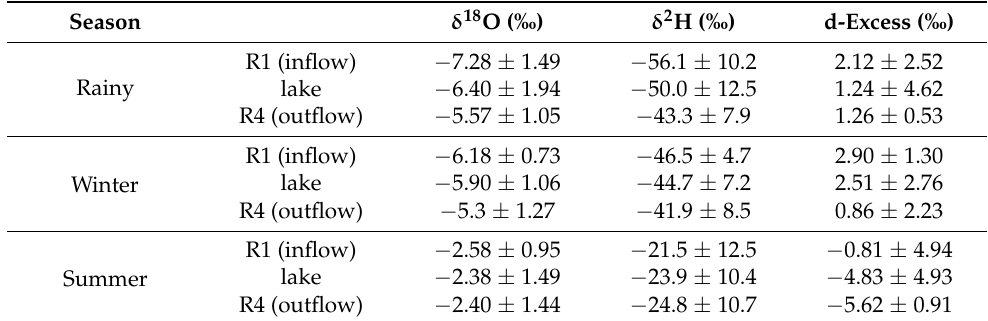
Table 1. Average and standard deviation of the isotopic composition and of the d-excess of surface water in the different seasons Season